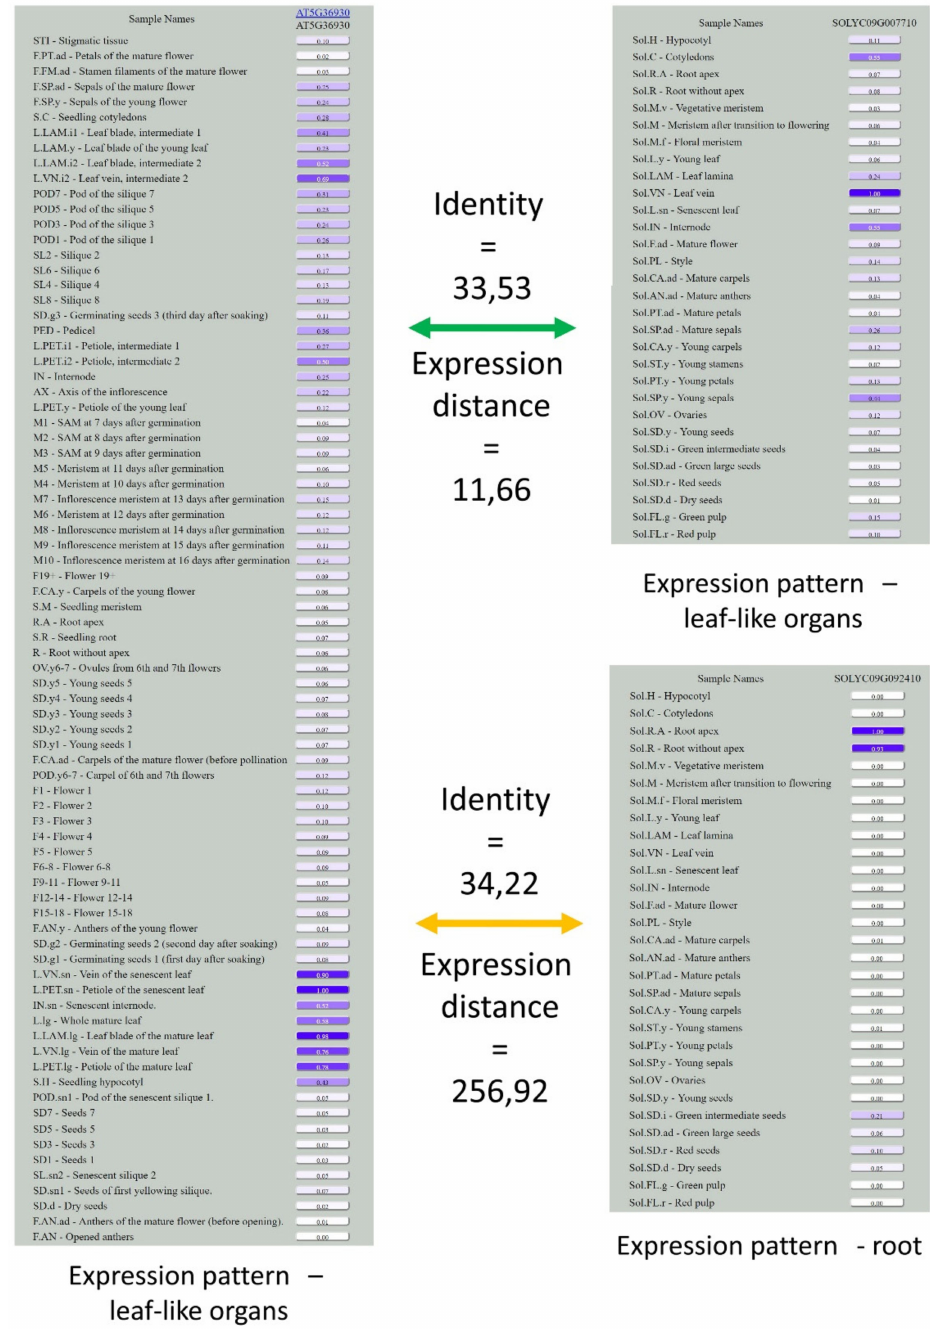
Figure 4. Expression patterns in ortho-triplet AT5G36930, Solyc09g092410, and Solyc09g007710. Identities are almost equal, while expression distances di ff er ~20-fold. Note that while Solyc09g007710, similar to AT5G36930, is expressed in leaves, Solyc09g092410 has a drastically di ff erent expression profile, with a maximum expression level in